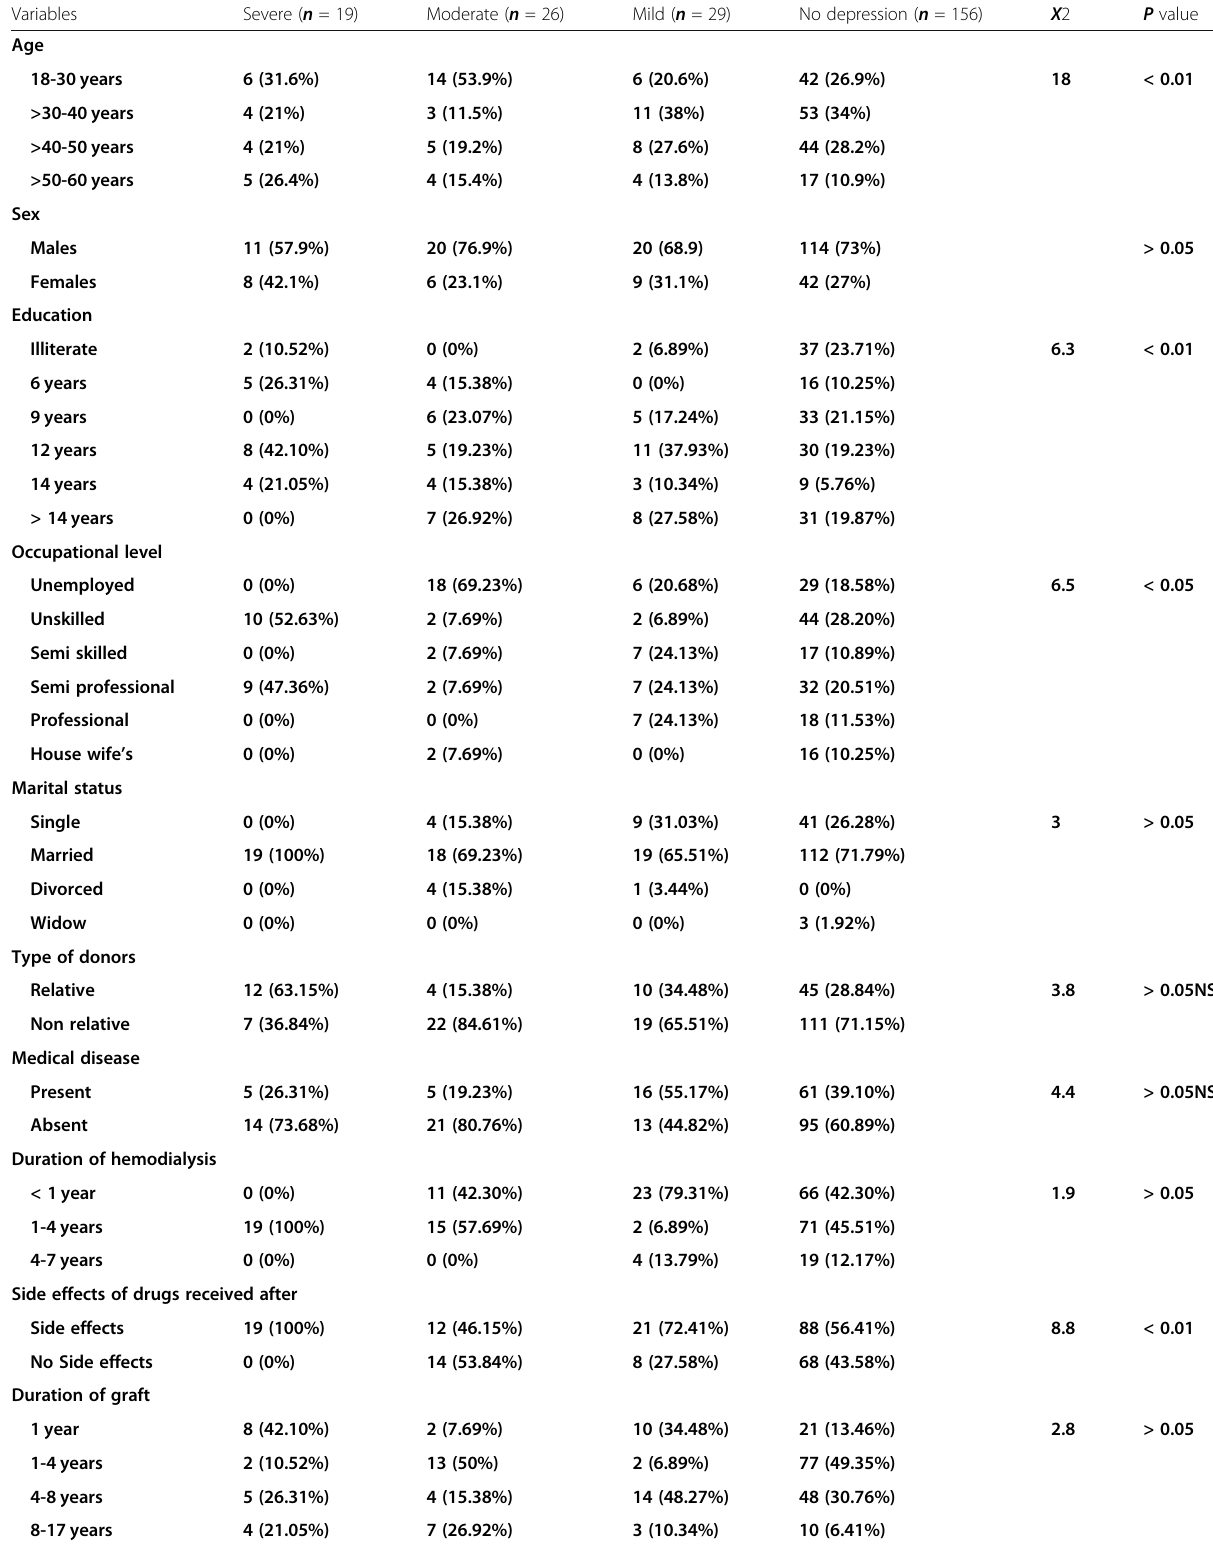
Table 1 Severity of depression in relation to sociodemographic and clinical variables in PRTRs